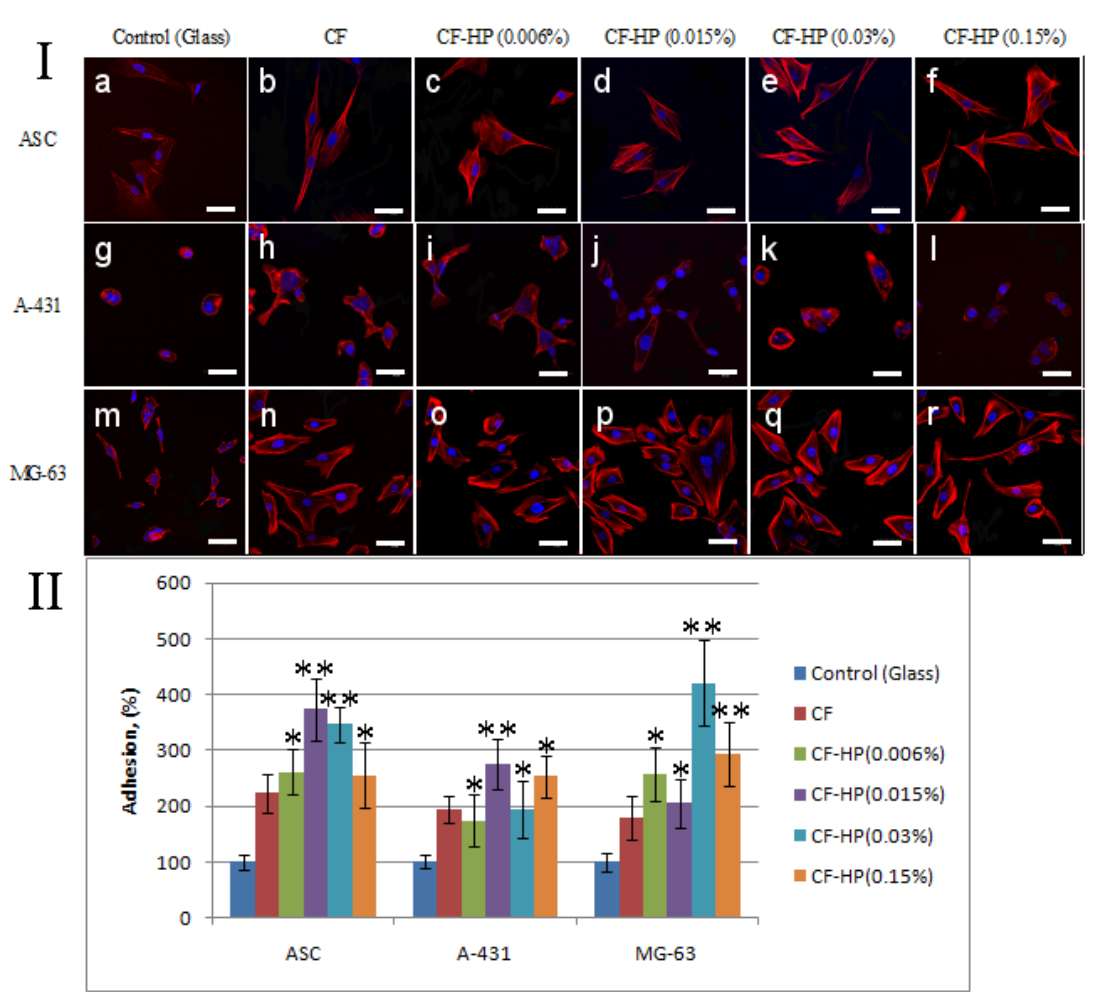
Figure 6. ( I ) Fluorescence micrographs of cells with actins (red) and nuclei (blue) stained after 1 day cultivation: ( a ) ASCs on the pure glass, ( b ) ASCs on the pristine CF, ( c ) ASCs on CF after HP treatment with concentration 0.006%, ( d ) ASCs on CF after HP treatment with concentration 0.015%, ( e ) ASCs on CF after HP treatment with concentration 0.03%, ( f ) ASCs on CF after HP treatment with concentration 0.15%, ( g ) A-431 on the pure glass, ( h ) A-431 on the pristine CF, ( i ) A-431 on CF after HP treatment with concentration 0.006%, ( j ) A-431 on CF after HP treatment with concentration 0.015%, ( k ) A-431 on CF after HP treatment with concentration 0.03%, ( l ) A-431 on CF after HP treatment with concentration 0.15%, ( m ) MG-63 on the pure glass, ( n ) MG-63 on the pristine CF, ( o ) MG-63 on CF after HP treatment with concentration 0.006%, ( p ) MG-63 on CF after HP treatment with concentration 0.015%, ( q ) MG-63 on CF after HP treatment with concentration 0.03%, ( r ) MG-63 on CF after HP treatment with concentration 0.15%. ( II ) Statistics of cell adhesion on surfaces with different functional groups after 1 h cultivation. (n = 5: *— p < 0.01, **— p < 0.05 compared with the unmodified CF.) Staining—rhodamine-phalloidin (red), 40,6-diamidino-2-phenylindole (DAPI) (blue). Scale bar 50 μ m.